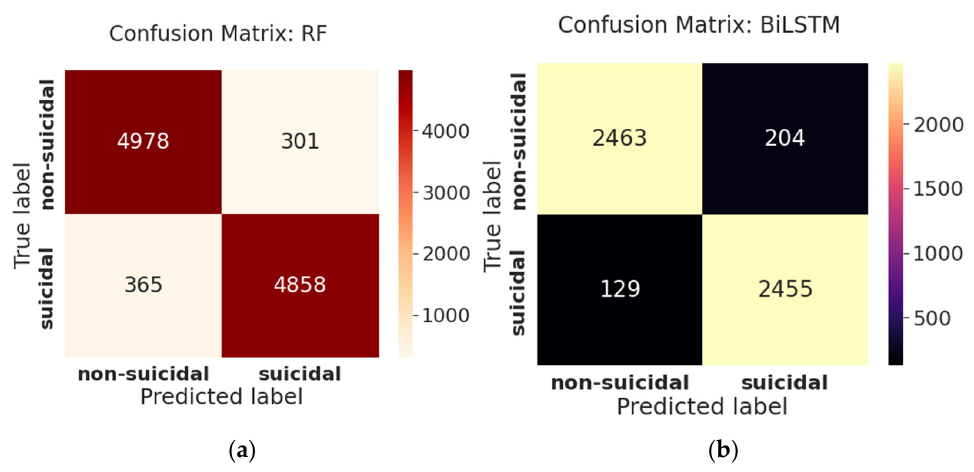
Figure 7. Confusion Matrix of best performed model of ML and DL ( a ) Random Forest; ( b ) BiLSTM.